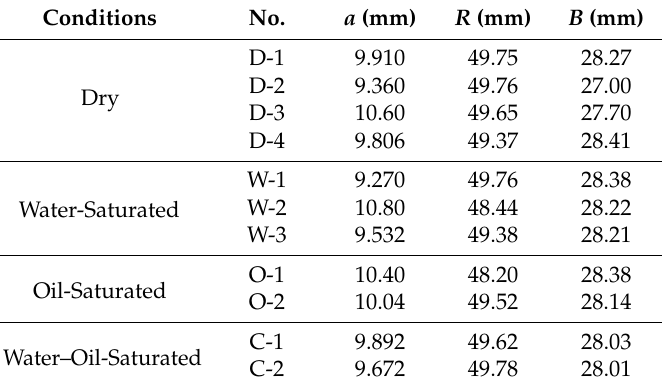
Table 2. Specific dimensions of the